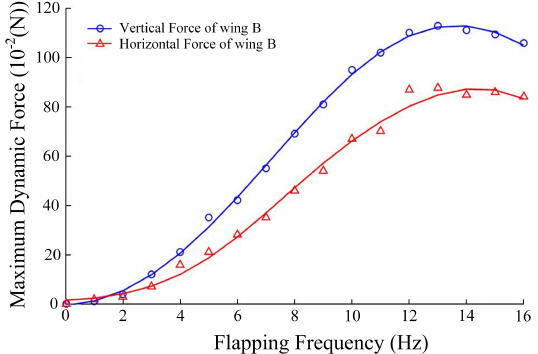
Figure 12. The maximum force of wing B of Type I vs. the flapping